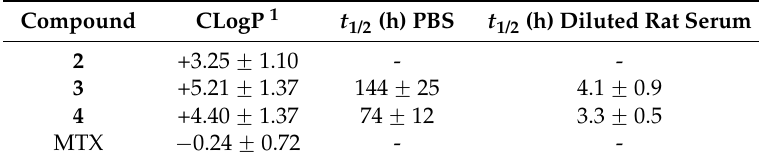
Table 1. Lipophilicity, permeation of blood-brain barrier (BBB) and stability in phosphate